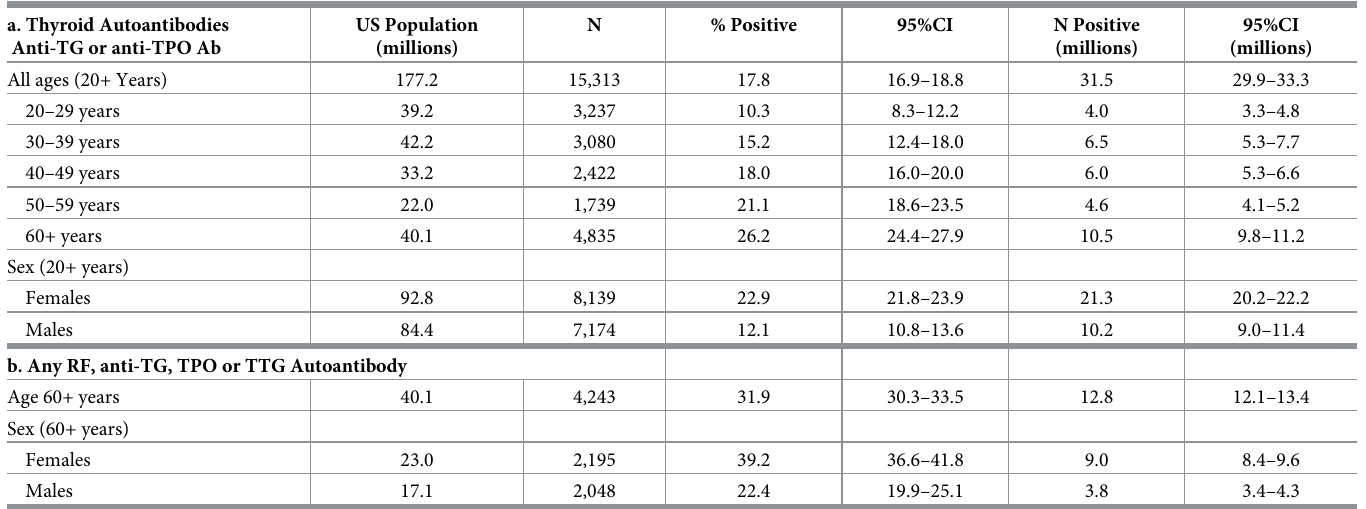
Table 5. US prevalence of a detectable serum autoantibody, NHANES